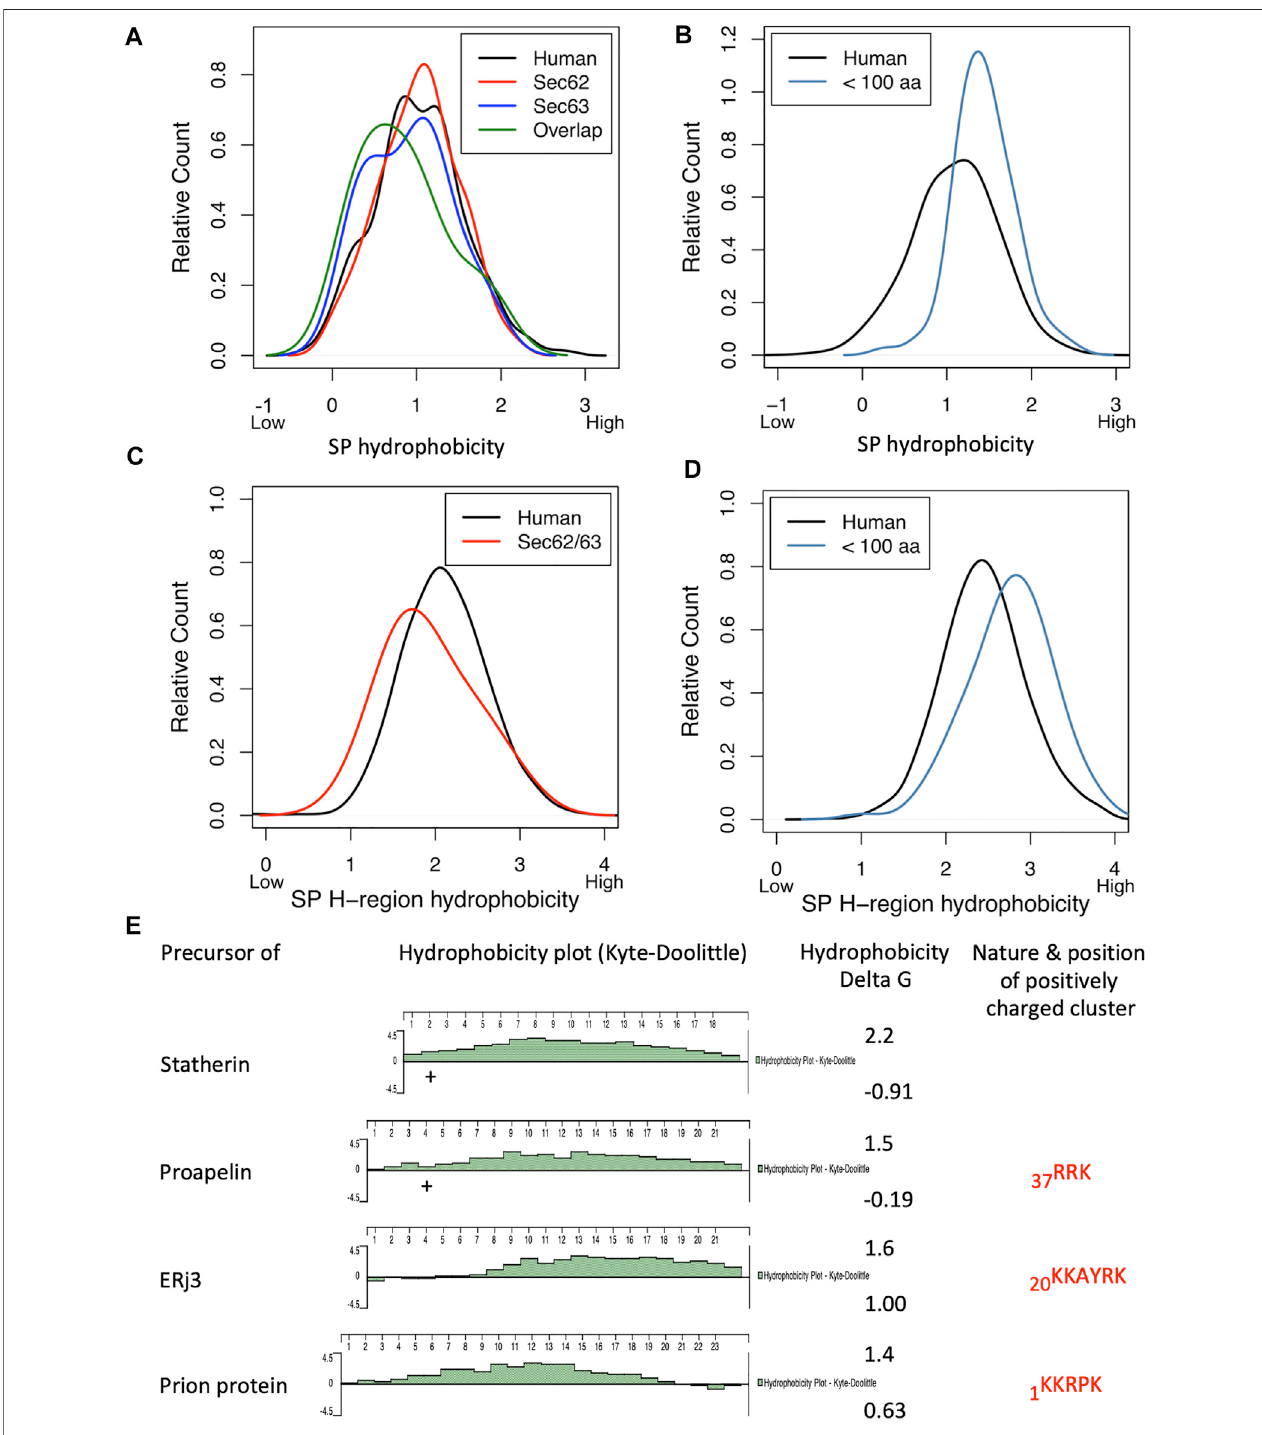
FIGURE 10 | Physicochemical properties of Sec62/Sec63 clients. (A – C) We used custom scripts to compute the hydrophobicity of SPs (A,B) and SP H-regions (C,D) , respectively. Hydrophobicity score was calculated as the averaged hydrophobicity of its amino acids according to the Kyte-Doolittle propensity scale. For the calculation of H-region hydrophobicity, each SP was subjected to segmentation using the prediction tool Phobius (https://phobius.sbc.su.se) and the H-region to the calculationaccordingtoKyte-Doolittle. (E) RelevantpropertiesofSPs(hydrophobicityandpositivelychargedaminoacidresidues,respectively)andmatureregions offourclients.HydrophobicityscoreswerecalculatedaccordingtotheKyte-DoolittlepropensityscaleandaredisplayedusingtheDNAstarsoftwarepackage.Apparent deltaGvaluesweredetermined withthe Δ G app predictorforTMhelix insertion(http://dgpred.cbr.su.se).Clustersofpositivechargesintherespectivematureregionthat were experimentally shown to contribute to Sec62/Sec63 dependence are indicated.